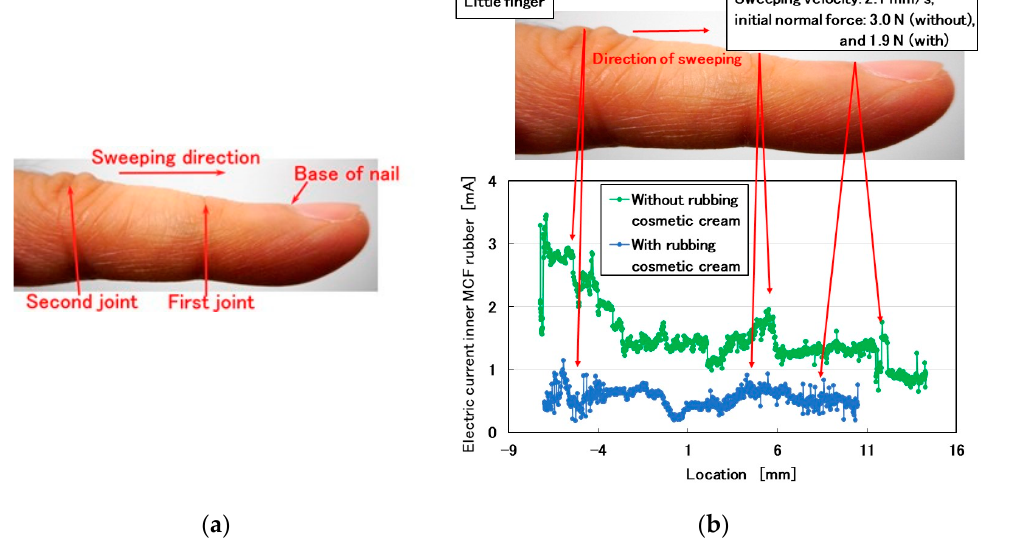
Figure 21. In case of rubbing little finger by the MCF rubber sensor: ( a ) image of the little finger and sweeping direction; ( b ) surface roughness of little finger coated with and without cosmetic cream.